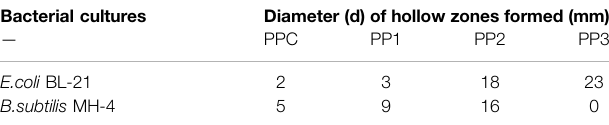
TABLE 1 | Antimicrobial potential of hydrogels in terms of inhibition zones. Bacterial